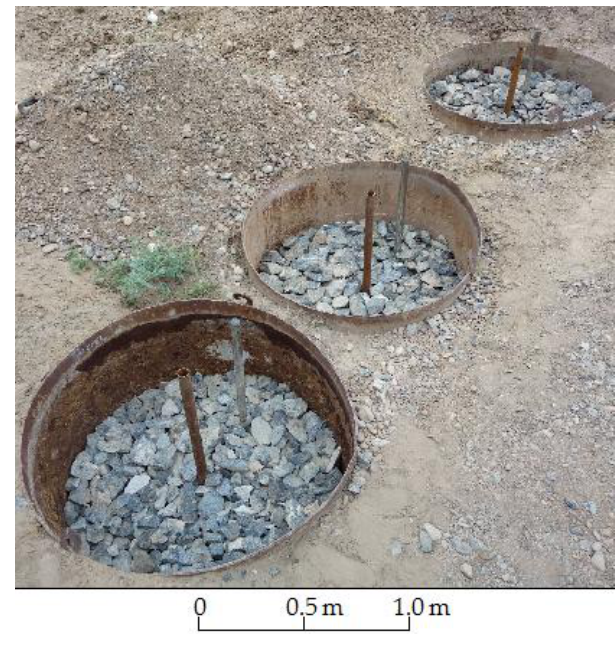
Figure 4. Backfilled waste rock in lower part of test barrels.